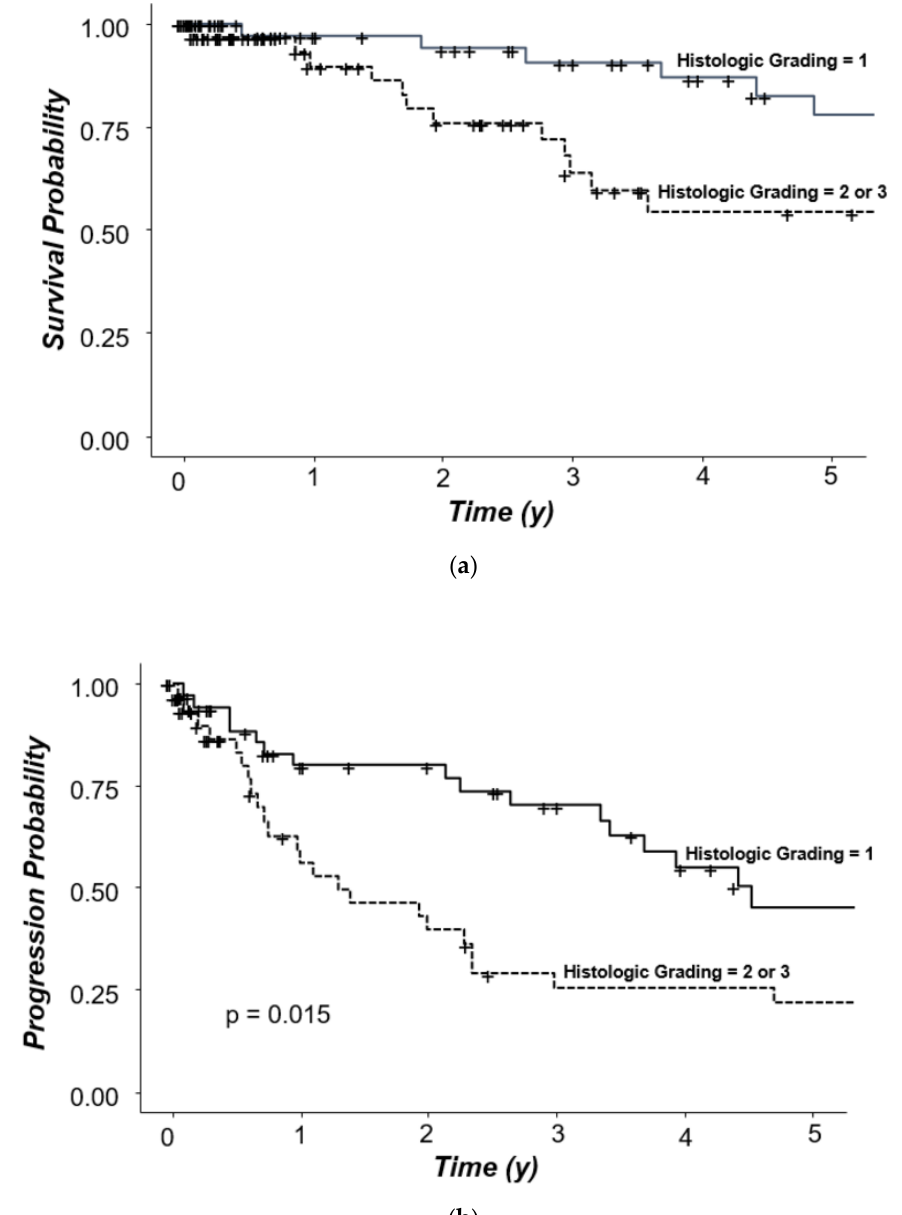
Figure 6. ( a ): Survival probability according to histological grading, all patients. ( b ): Progression probability according to histological grading, all patients.